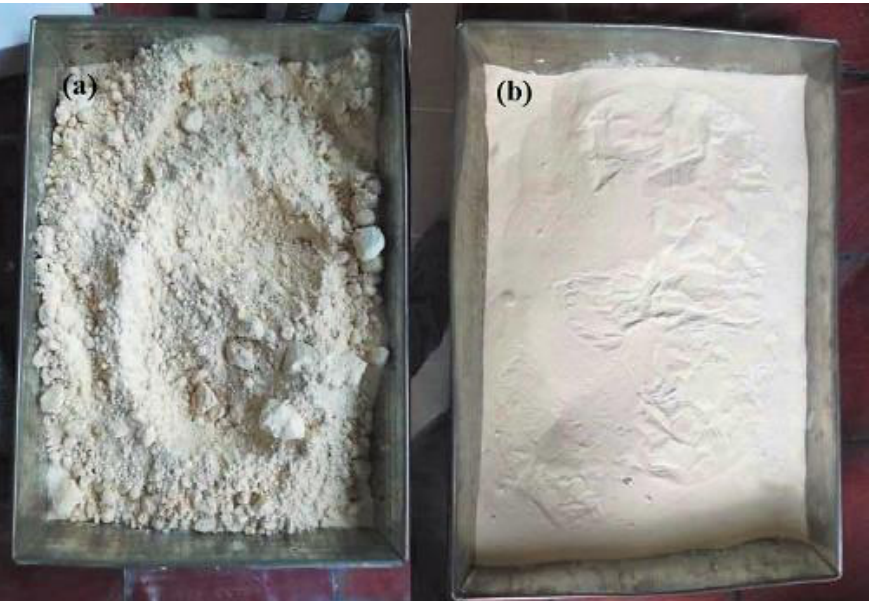
Figure 4. The appearance of gypsum: ( a ) before the calcination process, ( b ) after the calcination process [50].